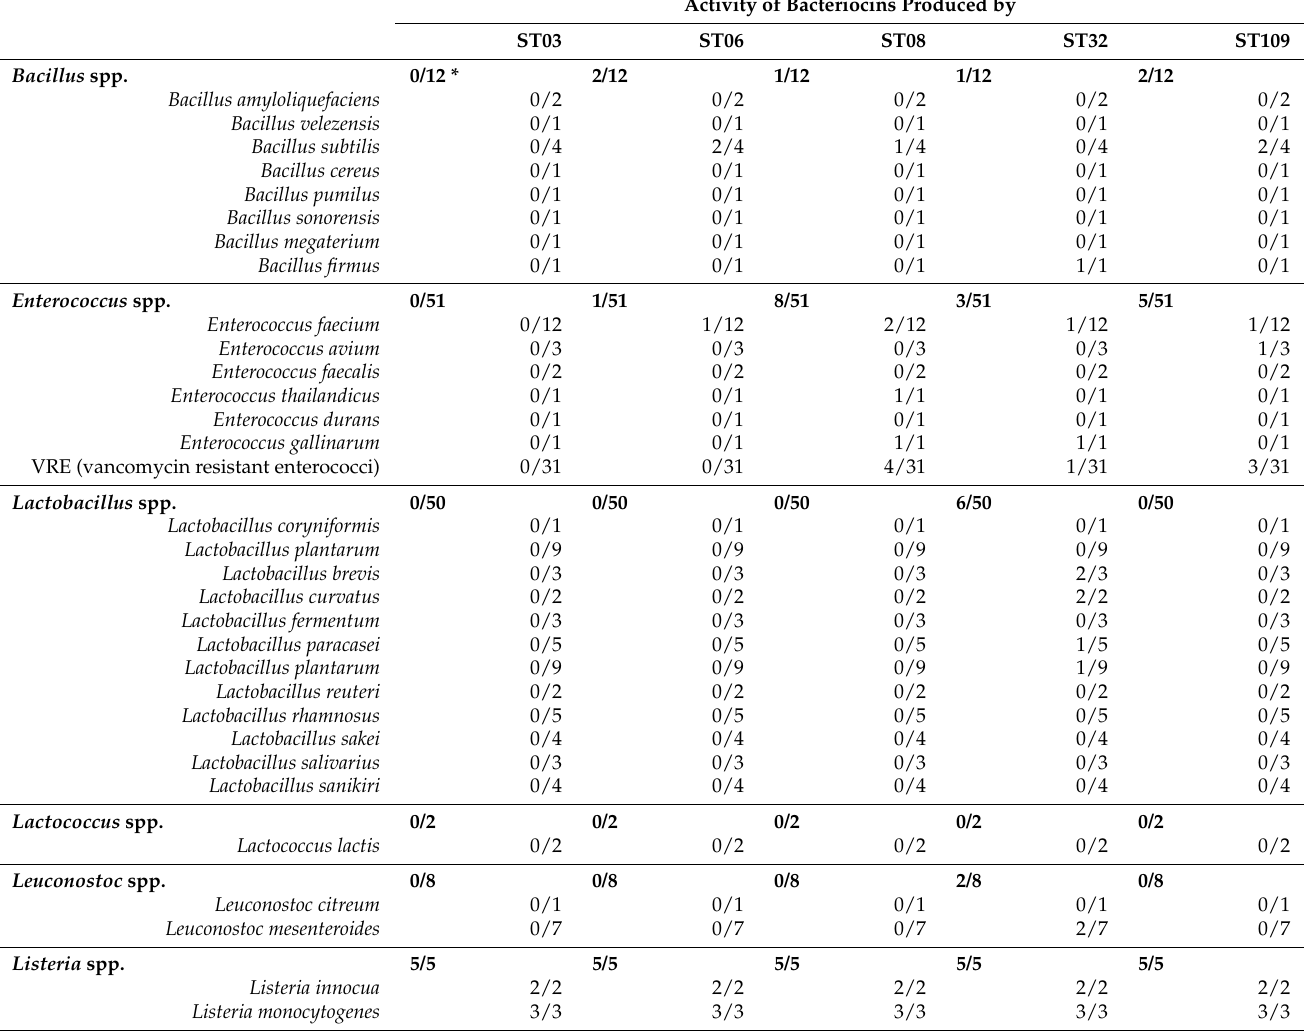
Table 1. Spectrum of activity of supernatants from B. velezensis ST03, B. amyloliquefaciens ST06, B. subtilis ST08, B. velezensis ST32, and B. amyloliquefaciens ST109 against selected bacteria from different culture collections. Activity of Bacteriocins Produced by ST03 ST06 ST08 ST32 ST109 Bacillus spp.